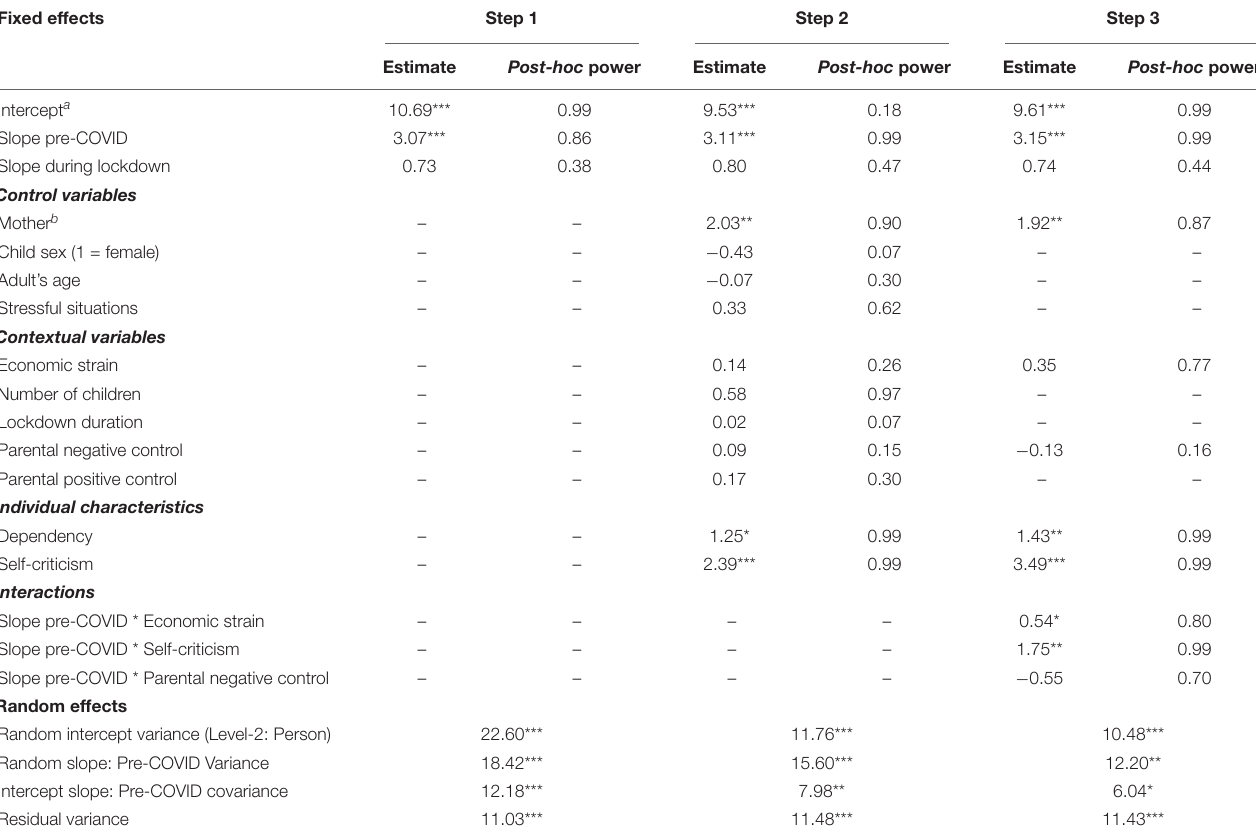
TABLE 4 | Model of individual and contextual variables on parental